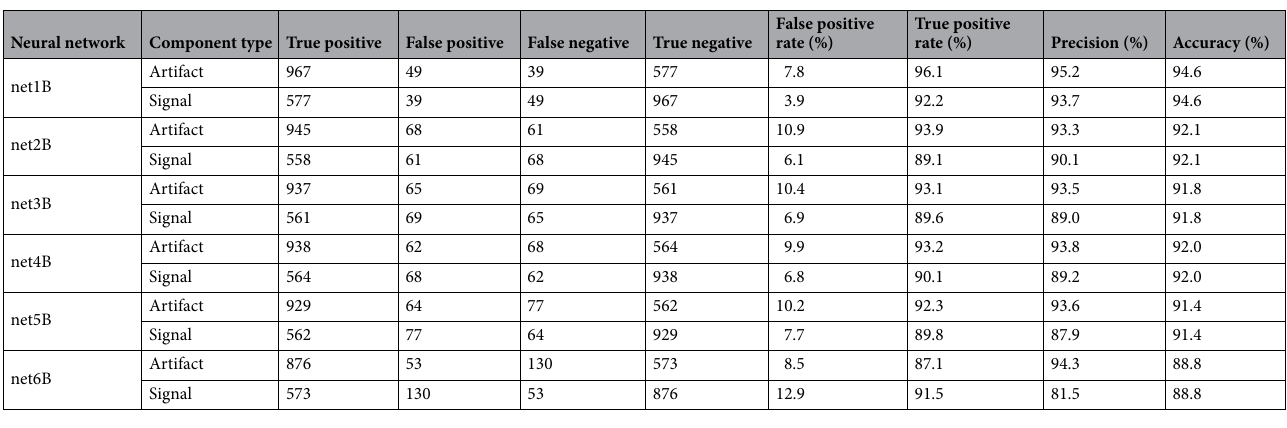
Table 4. Common performance metrics calculated from confusion